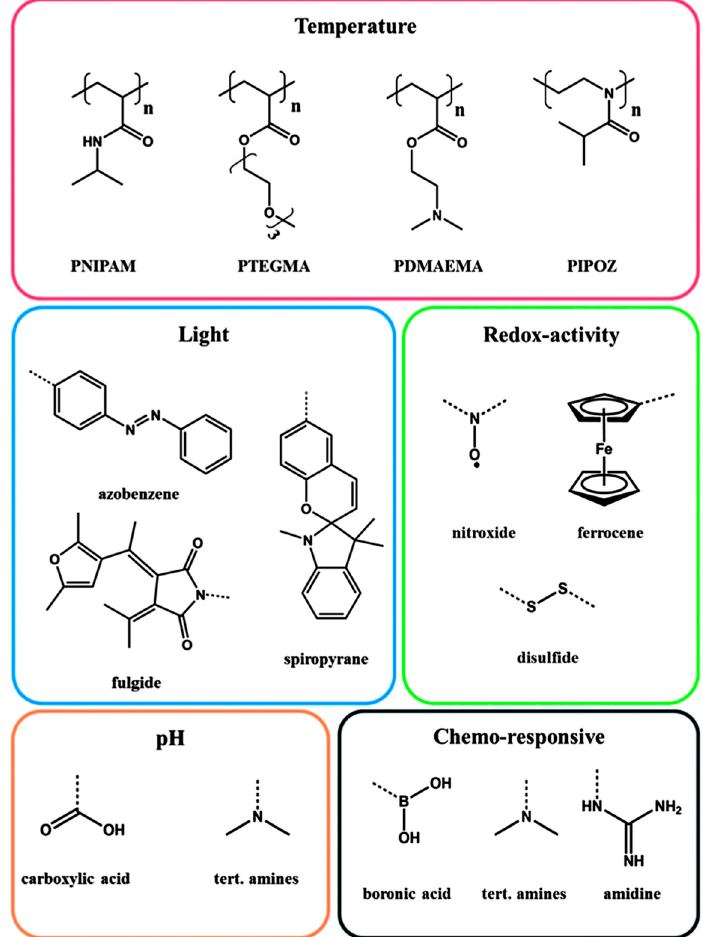
Figure 9. Examples of stimuli-responsive functional groups. Reprinted from [67]. Copyright (2022), with permission from Elsevier [or applicable society copyright owner].